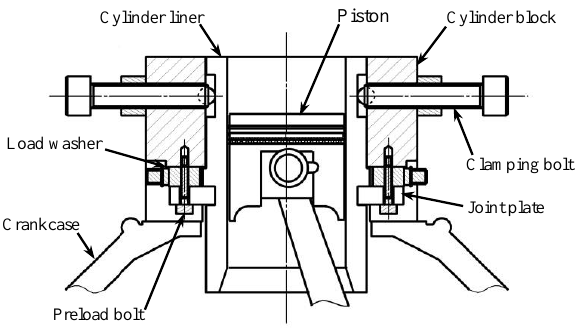
Fig. 2. Measurement unit of piston assembly friction with floating liner